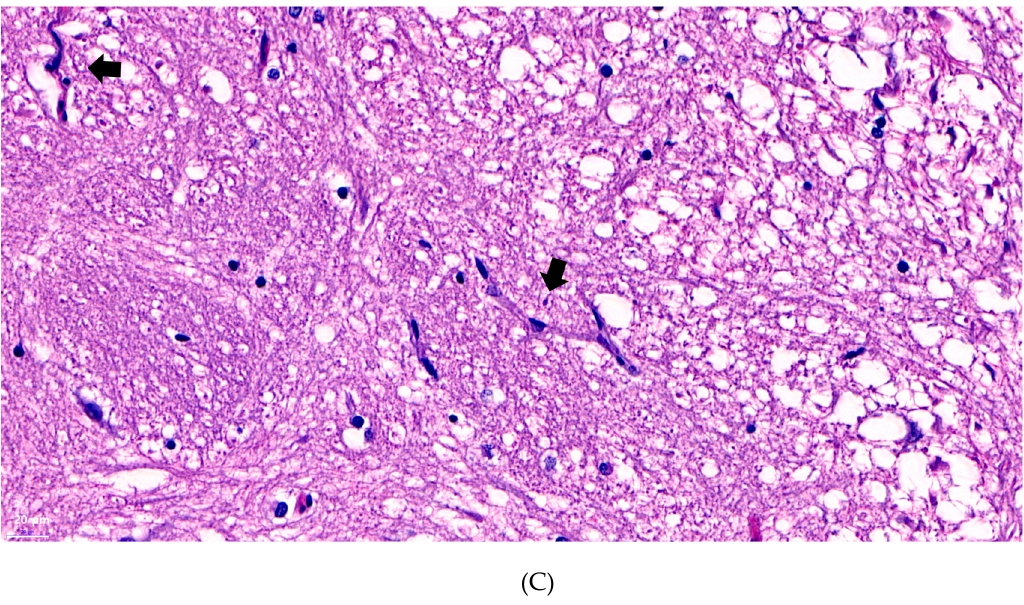
Figure 4. ( A ) Infiltration of eosinophilic granular leukocytes that are abundant along the cranial nerve root and ganglia (arrows defining eosinophilic leukcoytes lesion, bar: 10 µ m). ( B ) Microglia observed in the optic lobe of diseased fish (arrows defining microglia, bar: 10 µ m). ( C ) Signs of microgliosis observed in the optic lobe of the diseased fish (arrows defining signs of microgliosis, bar: 20 µ m).